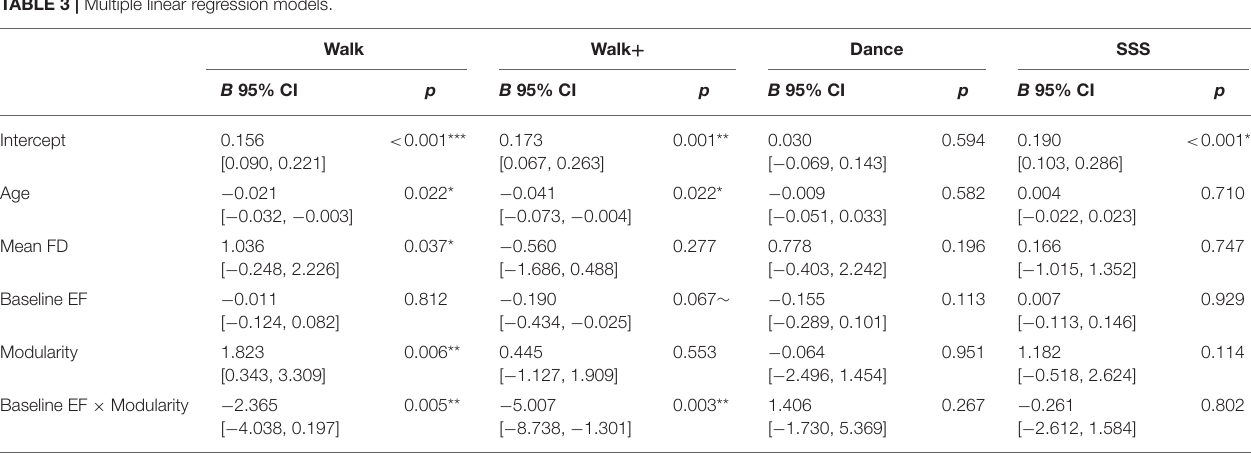
TABLE 3 | Multiple linear regression